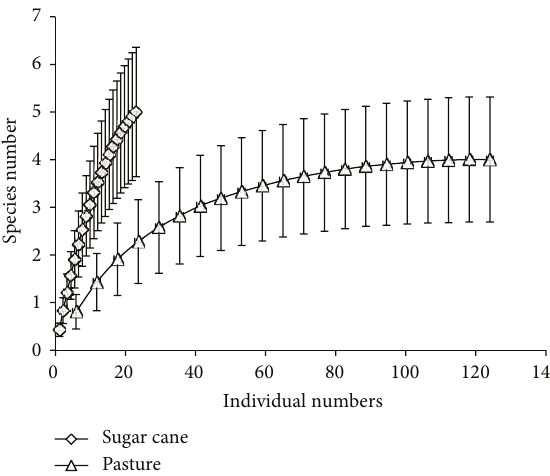
Figure 3: Individual-based rarefaction curves of terrestrial amphib- ians in fragments of Semideciduous Seasonal Forest with three predominant matrix types (sugar cane and pasture), estimated from 500 randomizations in the order of the